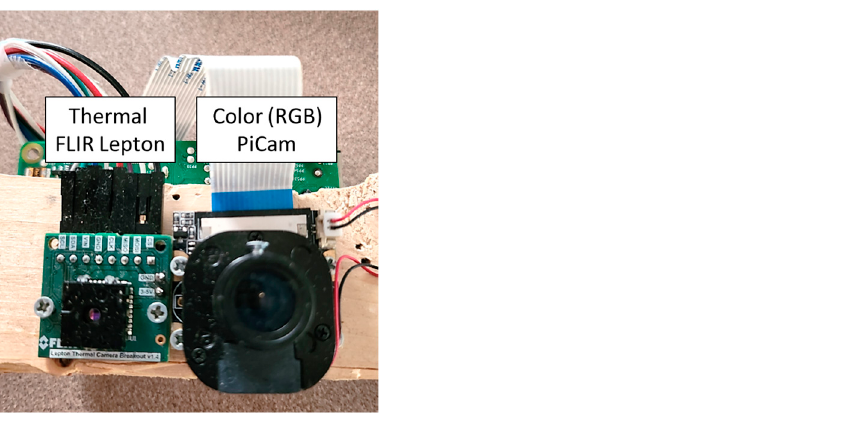
Table 1. Dataset: 6 Combinations of Food